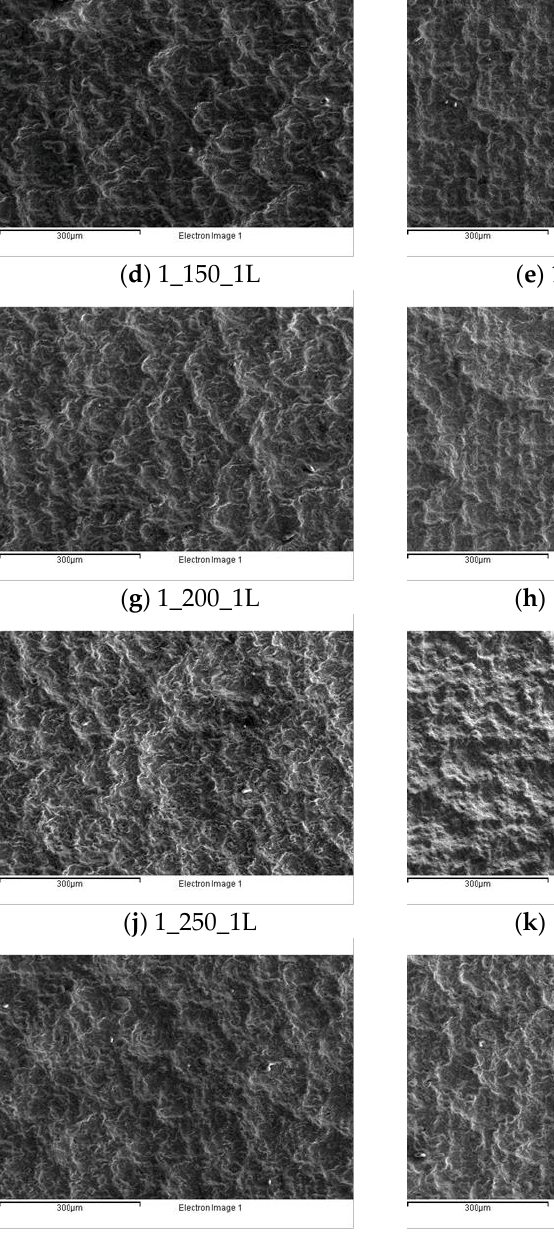
Figure 4 highlights that, from a quantitative point of view, the single-line strategy (1_L) was able to generate a pattern on the substrate only at a low scanning rate (see Figure 4a,d). To the contrary, when the laser scanning rate increased, tailored surfaces were generated in the case of the two- or three-line strategies (see Figure 4k,l). Moreover, compared with the initial morphology shown in Figure 1a, a smoother surface can be